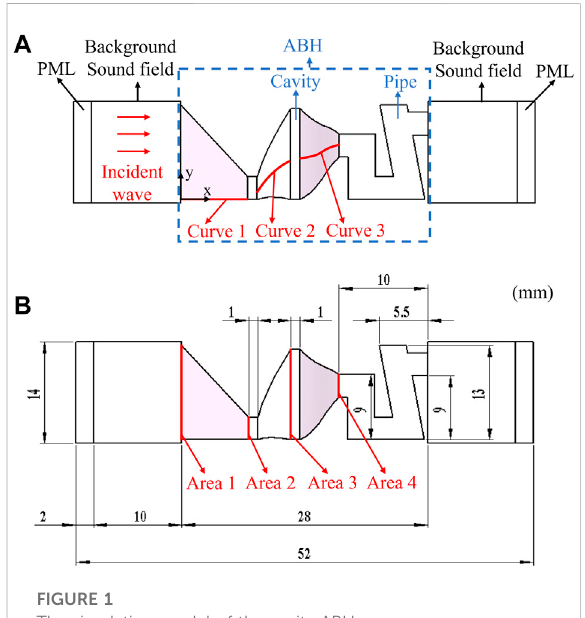
FIGURE 1 The simulation model of the cavity ABH.